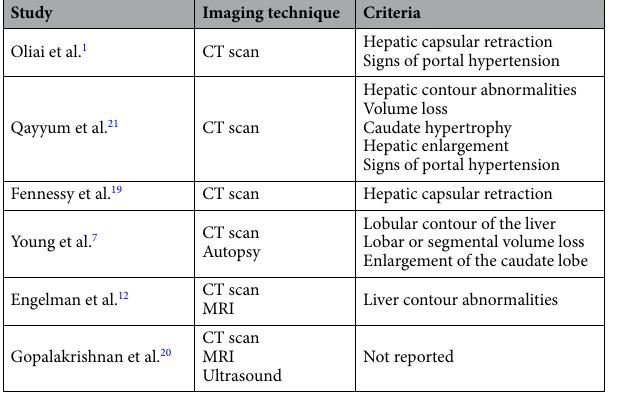
Table 5. Radiologic criteria used for the diagnosis of pseudocirrhosis reported by observational studies.